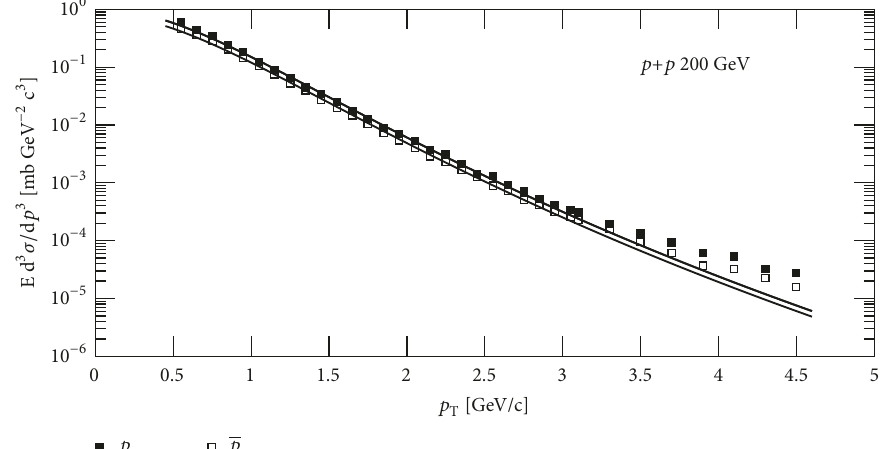
Figure 3: The transverse momentum distributions of 𝑝 and 𝑝 produced in 𝑝+𝑝 collisions at √𝑠 = 200 GeV in the whole measured 𝑝 𝑇 range. The solid squares and squares represent the experimental data of the PHENIX Collaboration [45]. The solid curves are the results calculated from Equation